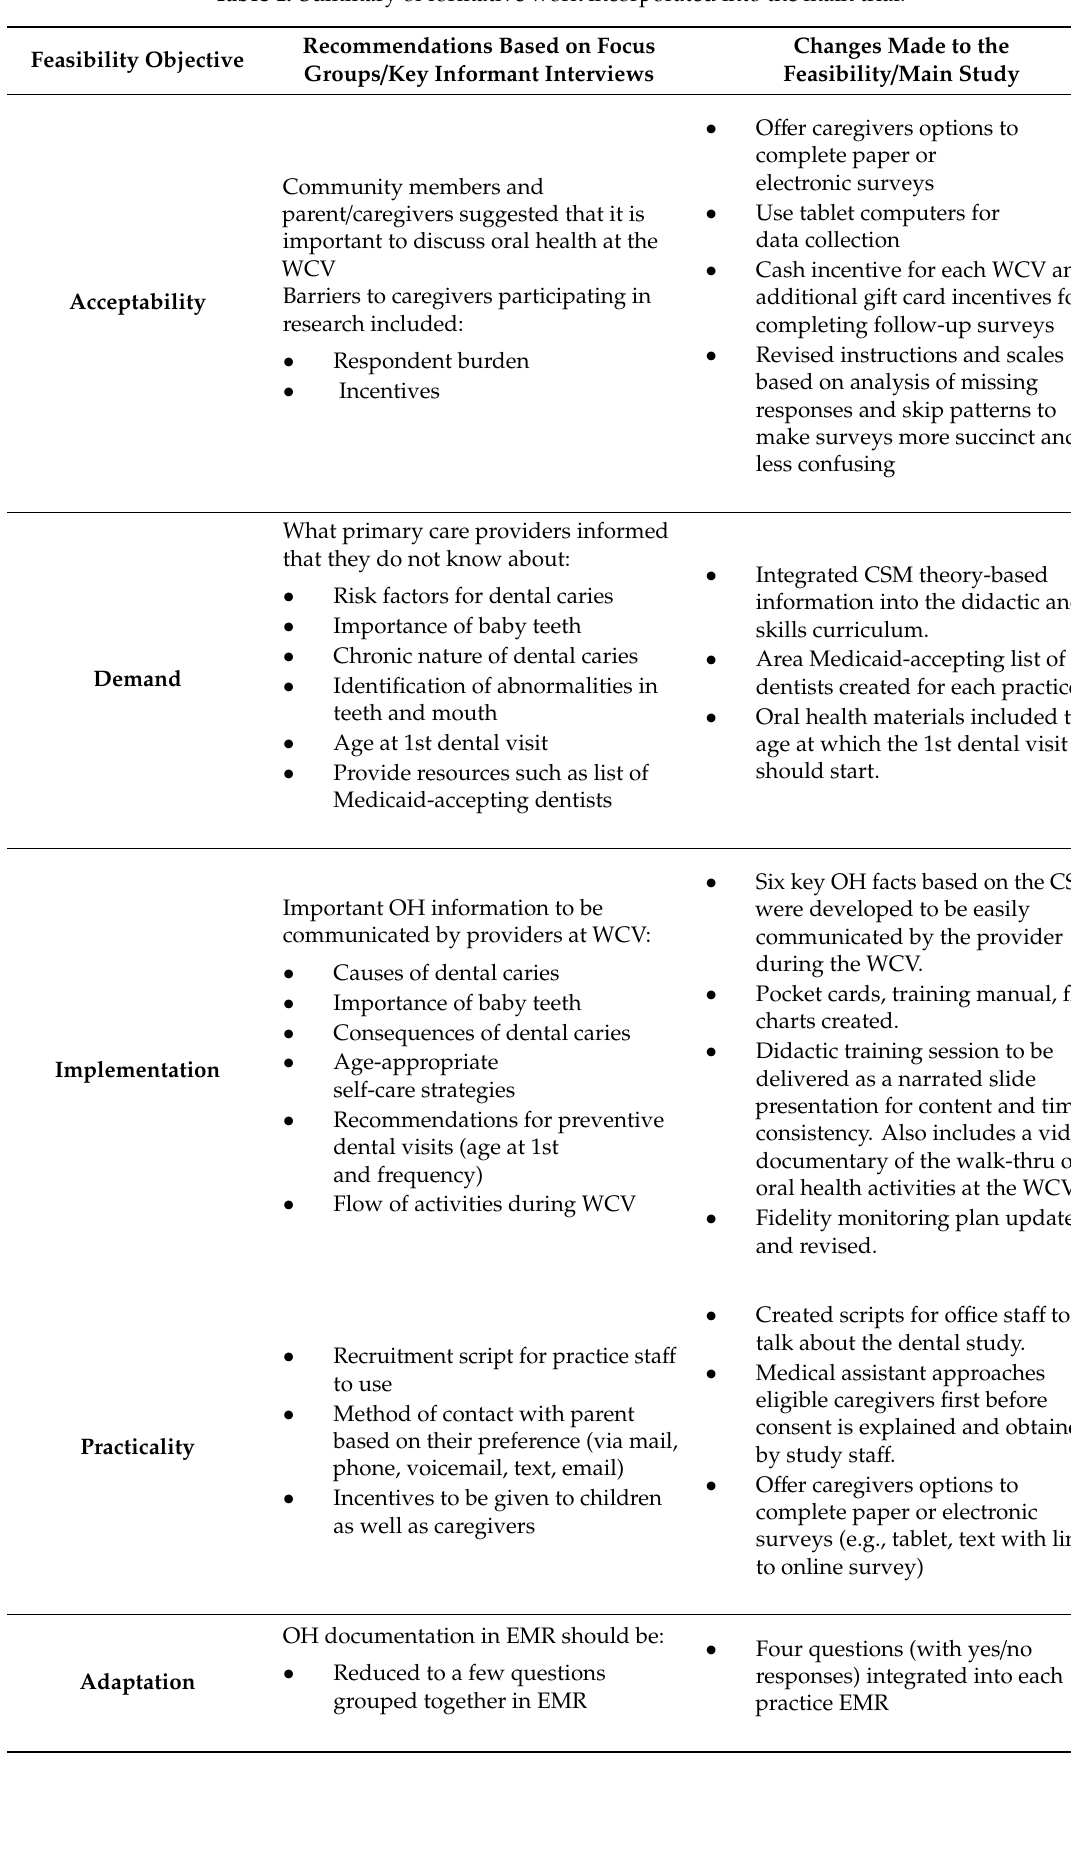
Table 1. Summary of formative work incorporated into the main